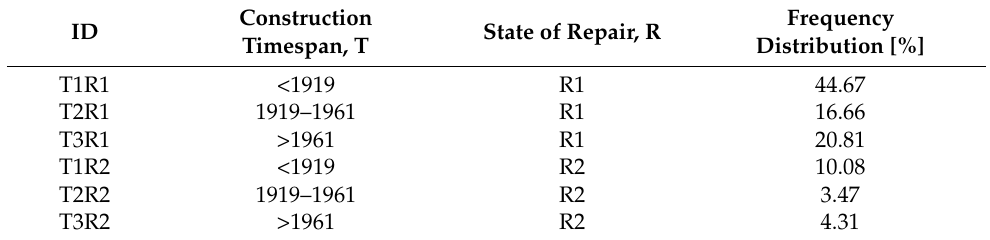
Table 2. Census building typological classification and relative frequency distribution of the in- creased